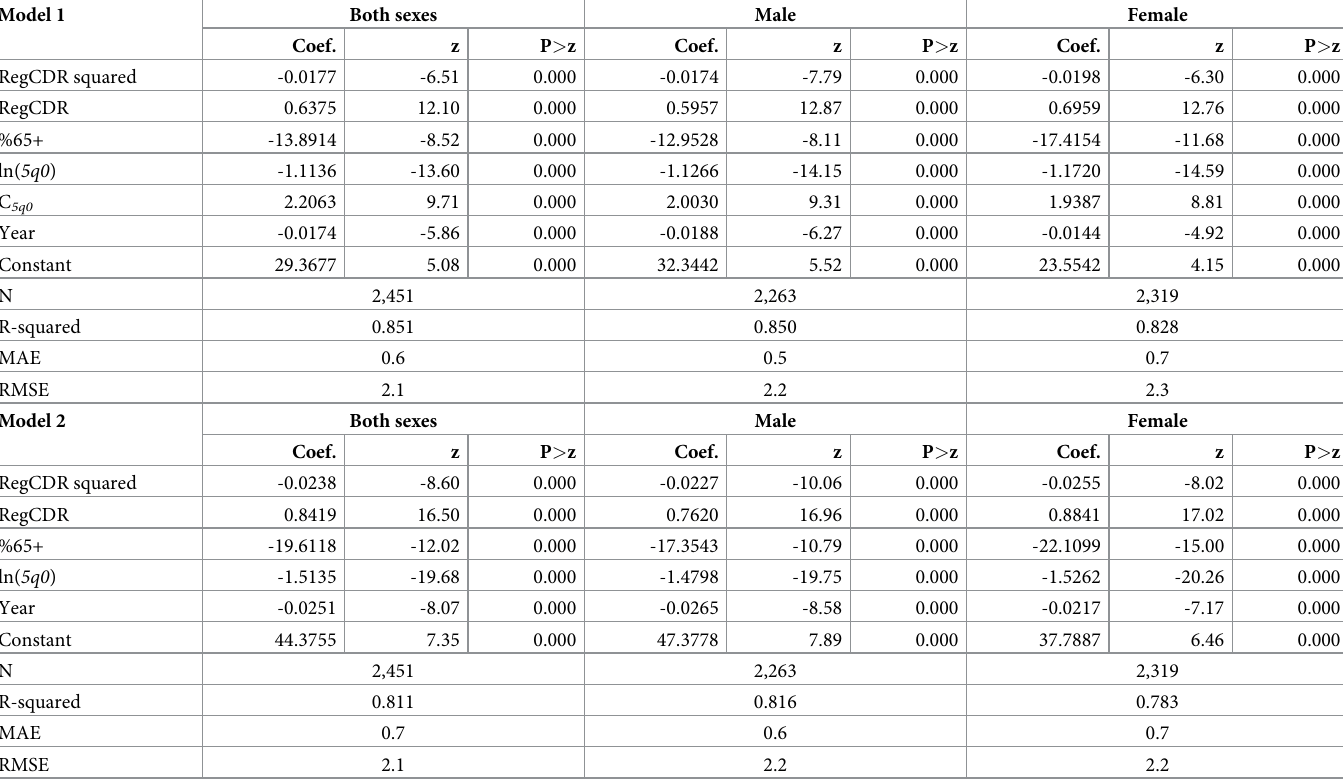
Table 2. Results from models of death registration completeness, both sexes, males and females. Model 1